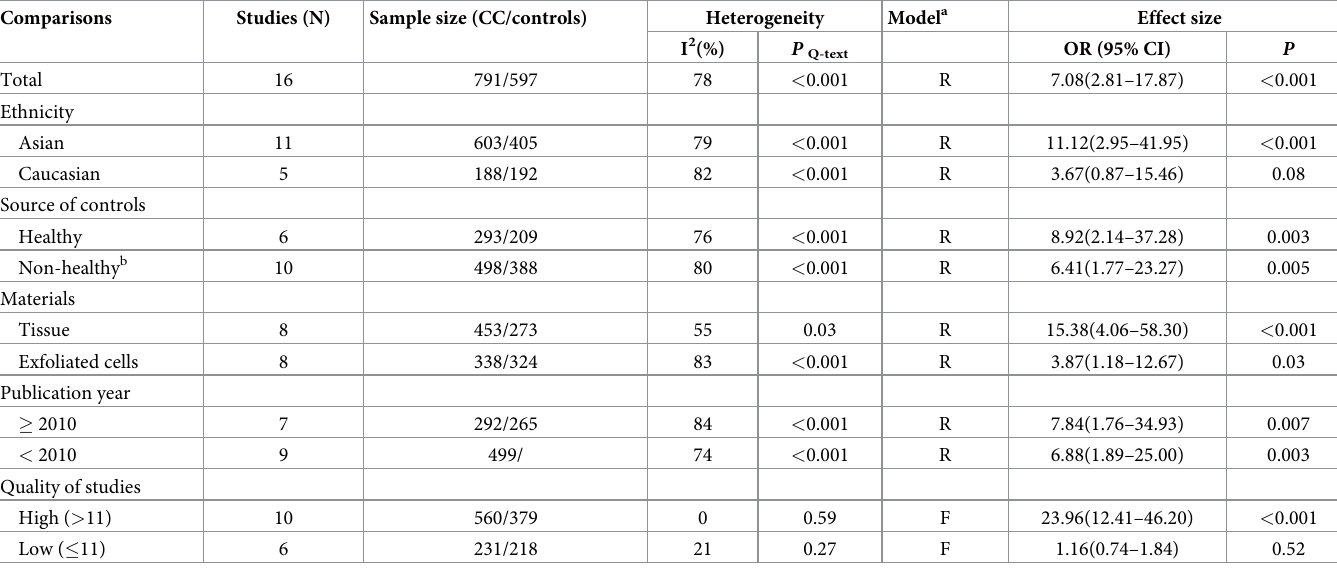
Table 5. Pooled results for the association of MGMT promoter hypermethylation with